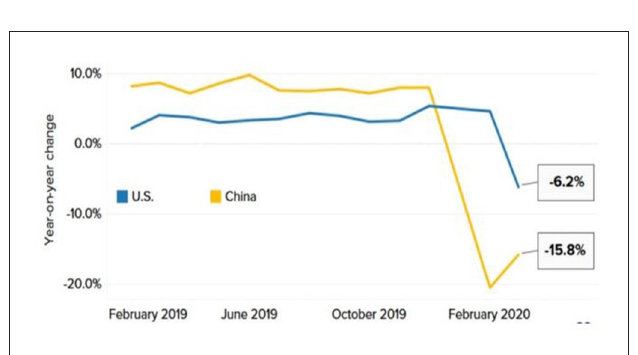
FIGURE6 Plunge in retail sales. Source: U.S. Census Bureau, National Bureau of Statistics of China, Refinitiv.